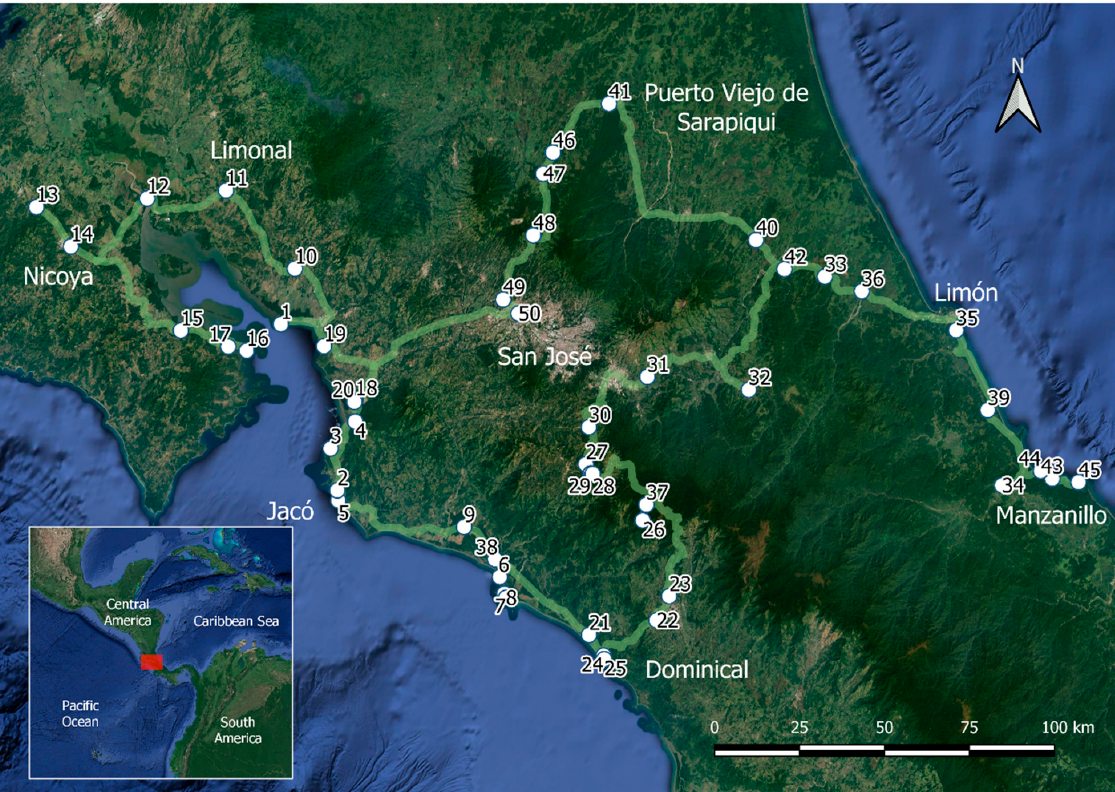
Figure 3. LAP sites indicated with white dots (number codes as in Appendix A, Tables A1 and A2). Route taken on the sampling survey expedition shown by light green line.